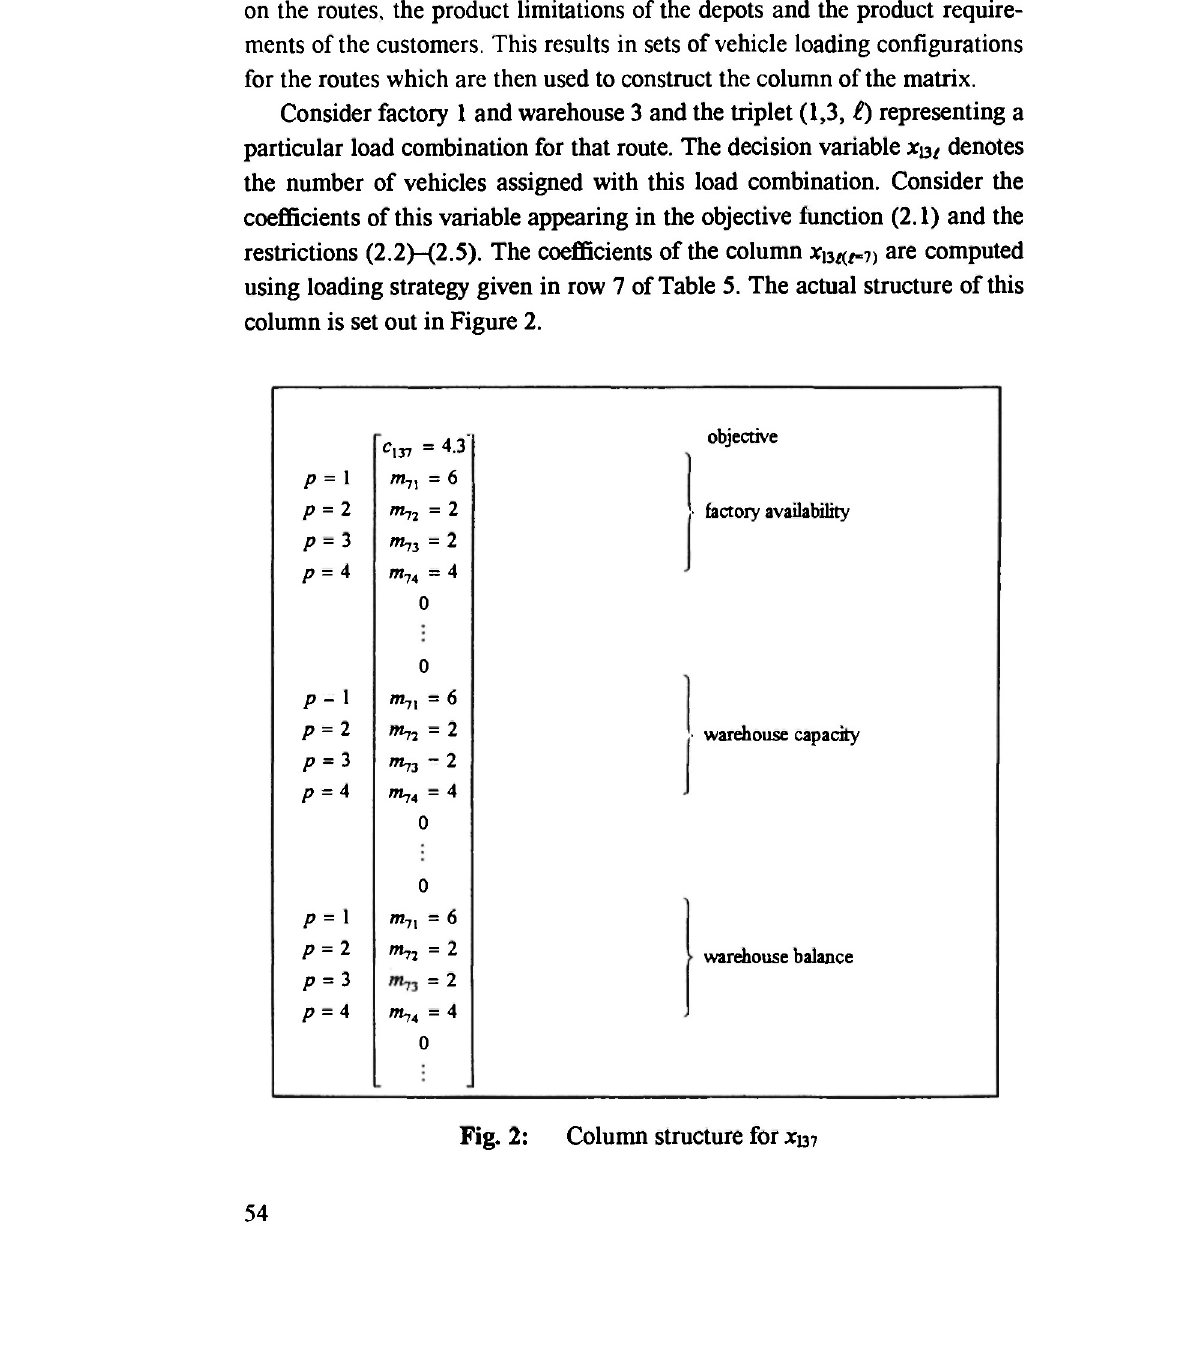
Fig. 2: Column structure for xi